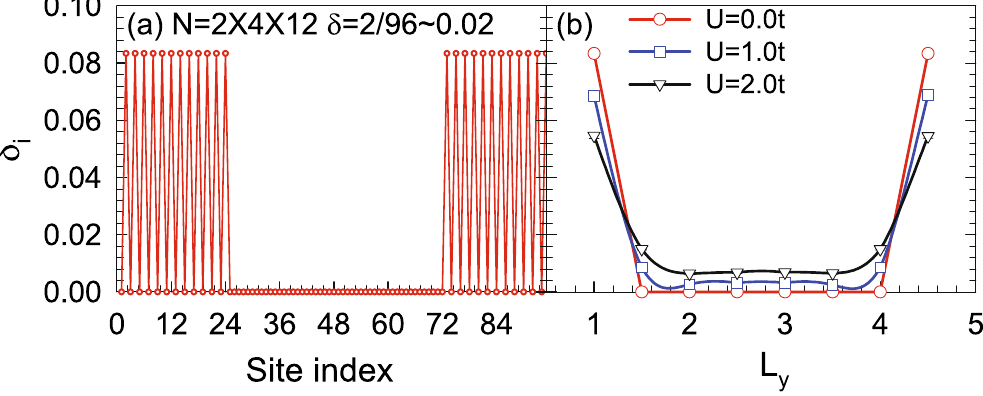
Figure 2. The carrier distribution ( a ) as a function of the site index at U = 2.0 t and ( b ) from edge → bulk → edge with different U . It is clear to see that most charge carriers are distributed along the